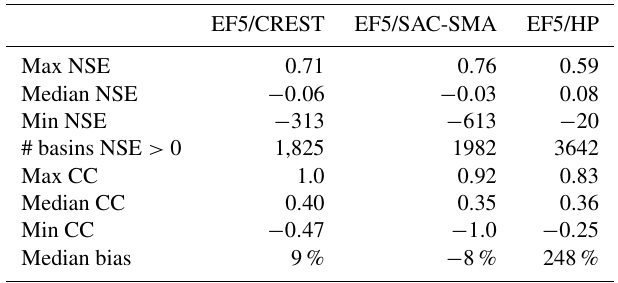
Table 6. Statistical summary of EF5